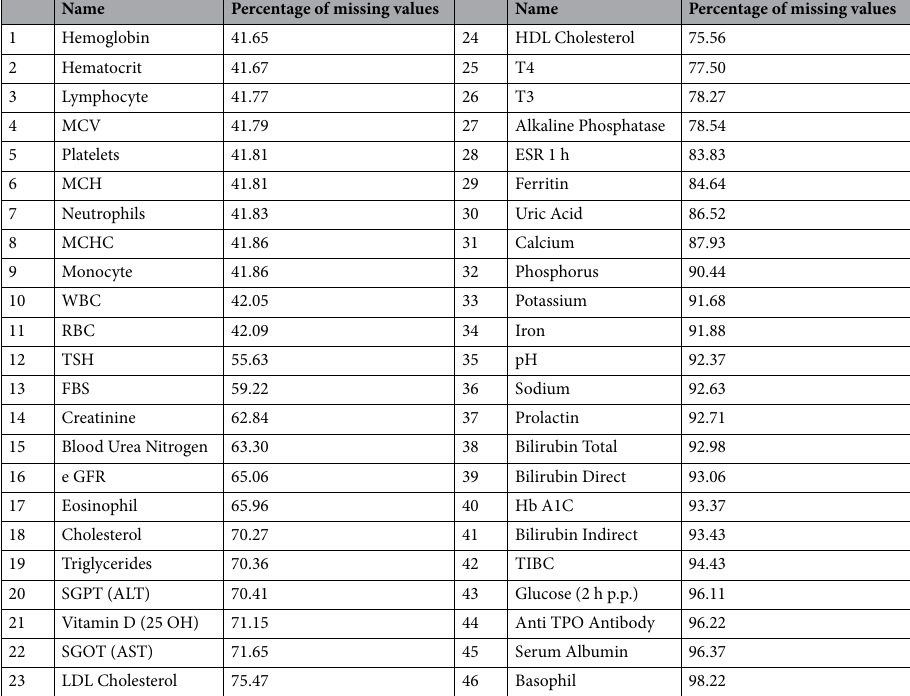
Table 1. Name and percentage of missing values for the blood test parameters included in the